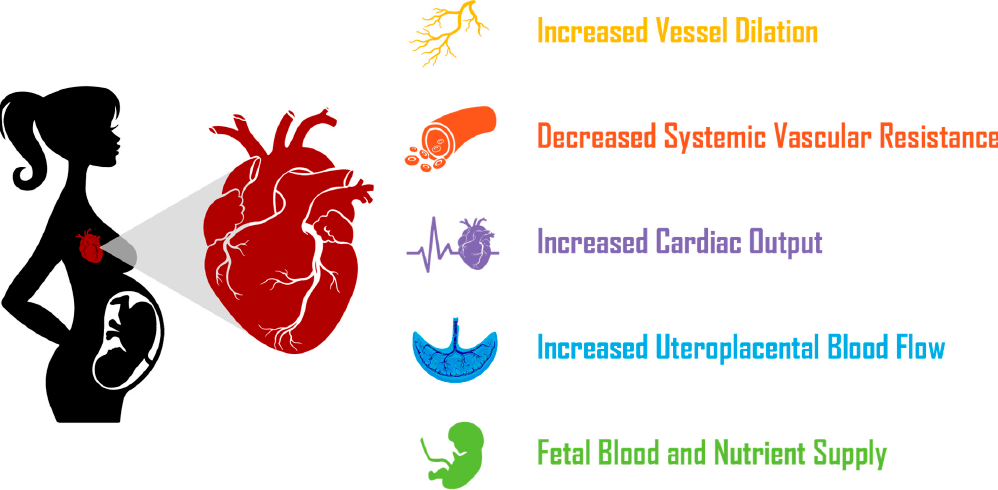
Figure 3. Cardiovascular adaptation during pregnancy. In pregnancy, cardiovascular adaptation leads to an increase in blood vessel dilation, an accompanying 20% decrease in systemic vascular resistance to accommodate the 40% increase in cardiac output. This adaptation thus increases utero- placental blood flow and increases nutrient and blood supply to the fetus.